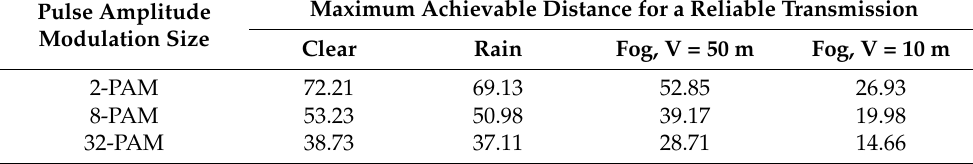
Table 5. Maximum achievable distance for a reliable transmission for different weather types, BER (bit error rate) = 10 − 6 and V (visibility). The table was constructed using data from